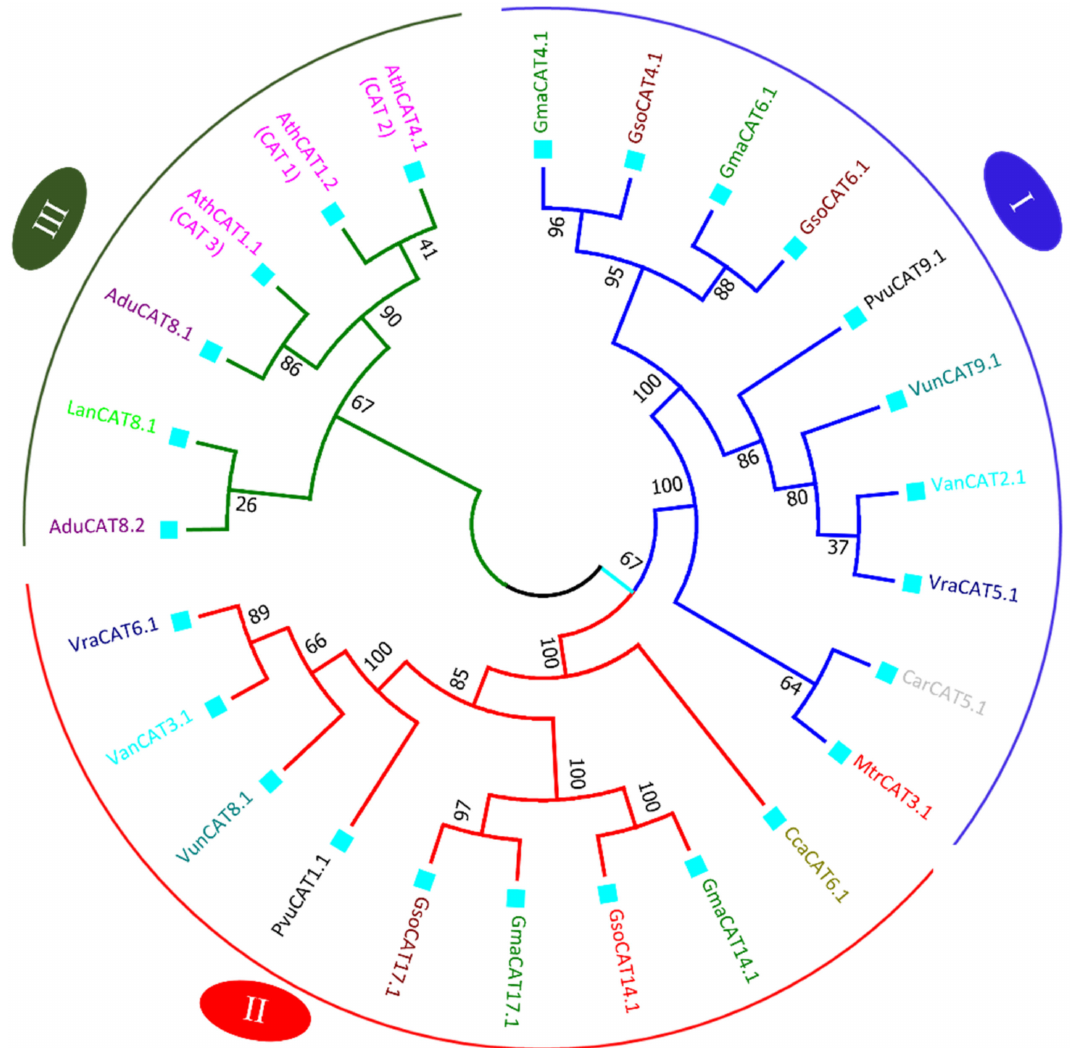
Figure 5. Phylogenic tree of CAT proteins. The tree was constructed in MEGA 7 using the neighbor- joining method with 1000 bootstraps. Different clades of trees are marked with different colors of branch lines: Clade I (blue), Clade II (red) and Clade III (green). The square boxes represent cellular localization: peroxisome